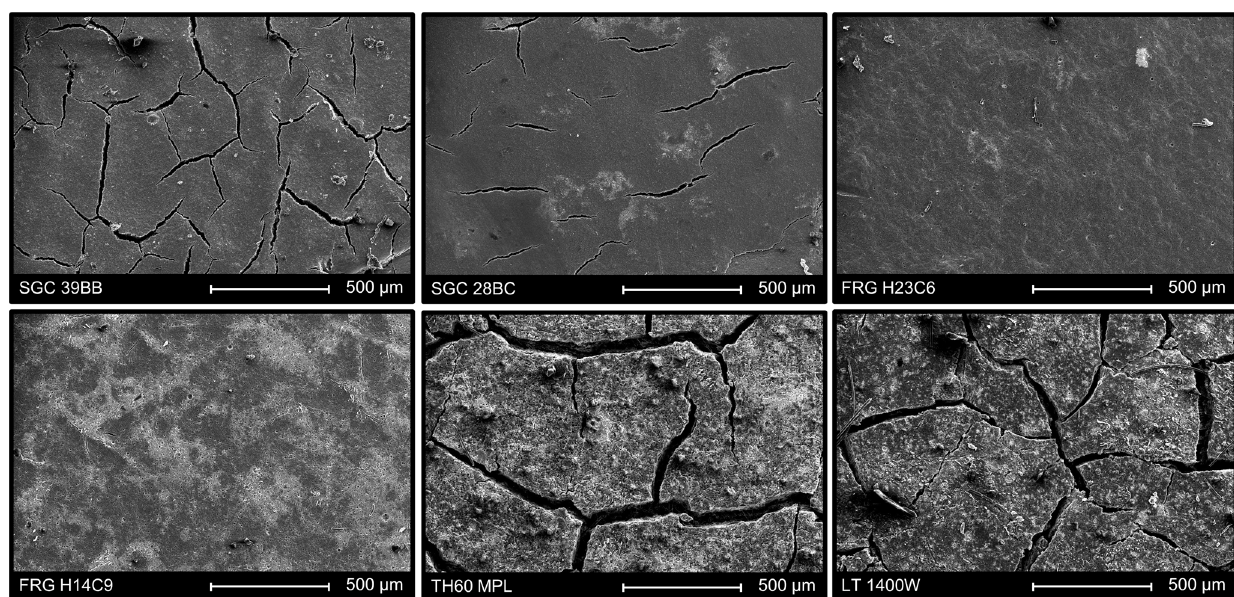
Fig. 5 Morphology of the microporous layer of different carbon gas diffusion layers. SEM images of the six selected gas diffusion layers ’ microporous layer